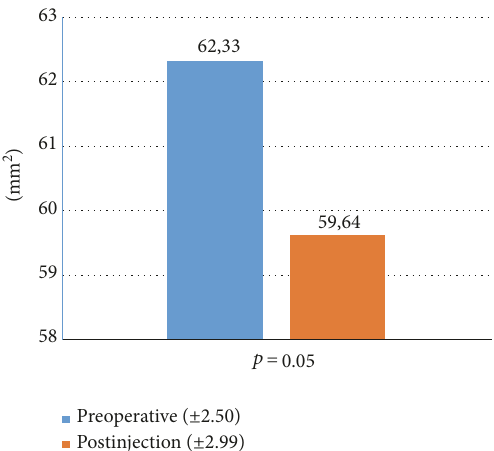
Figure 3: Mean changes in pterygium dimensions one week after fi rst subconjunctival bevacizumab injection in group A.